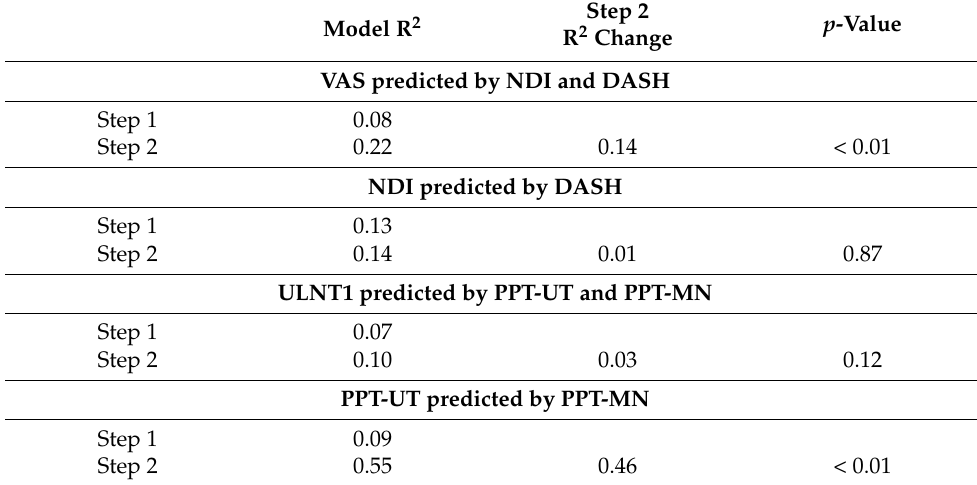
Table 6. Multiple linear regression analyses for the relationship between VAS, NDI, DASH, PPT, and ULNT1. Model R